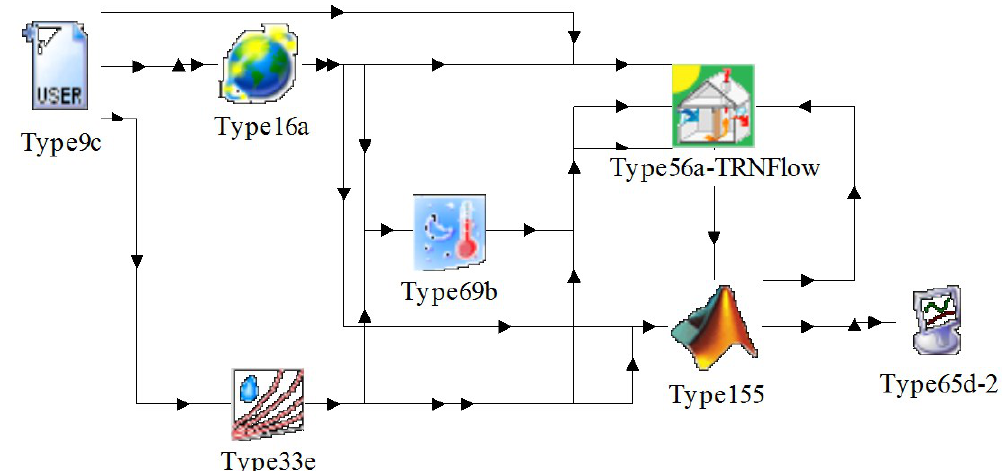
Figure 5. Modeling procedure of a test building using TRNSYS and